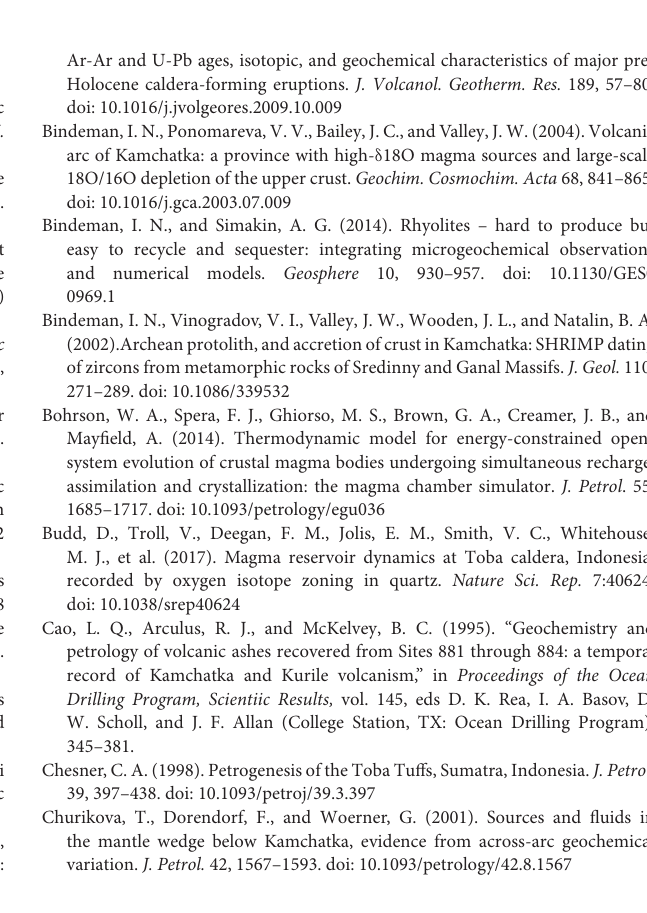
Table A1 | Chemical analyses of Karymshina Volcanic Center samples used in this study. Table A2 | Results from North Pacific tephra and Kamchatka volcano glass. Table A3 | Electron microprobe analyses of mineral phases and glass in ignimbrite and post-caldera extrusions. Done at University of Oregon (John Donovan, analyst). Table A4 | Details of Ar-Ar dating of studied samples. Figure A1 | Elemental temporal trends through Karymshina. Figure A2 | Plag-Qz plots for Karymshina rocks. Figure A3 | Results of rhyolite MELTS fractional crystallization at 8 and 2 kbars. Pressure with 2.5 wt% of H 2 O in the initial. Best match is provided by